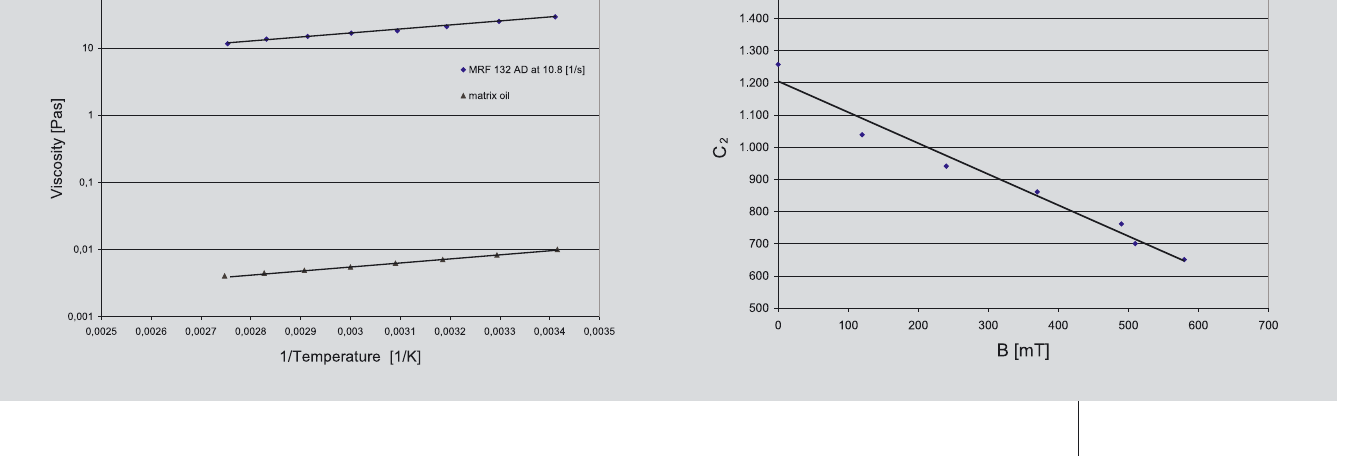
Figure 7 (left): Comparison of the temperature behavior of the matrix oil and the MRF 132 AD with no applied magnetic field. Figure 8 (right): C 2 as a func- tion of the magnetic flux density